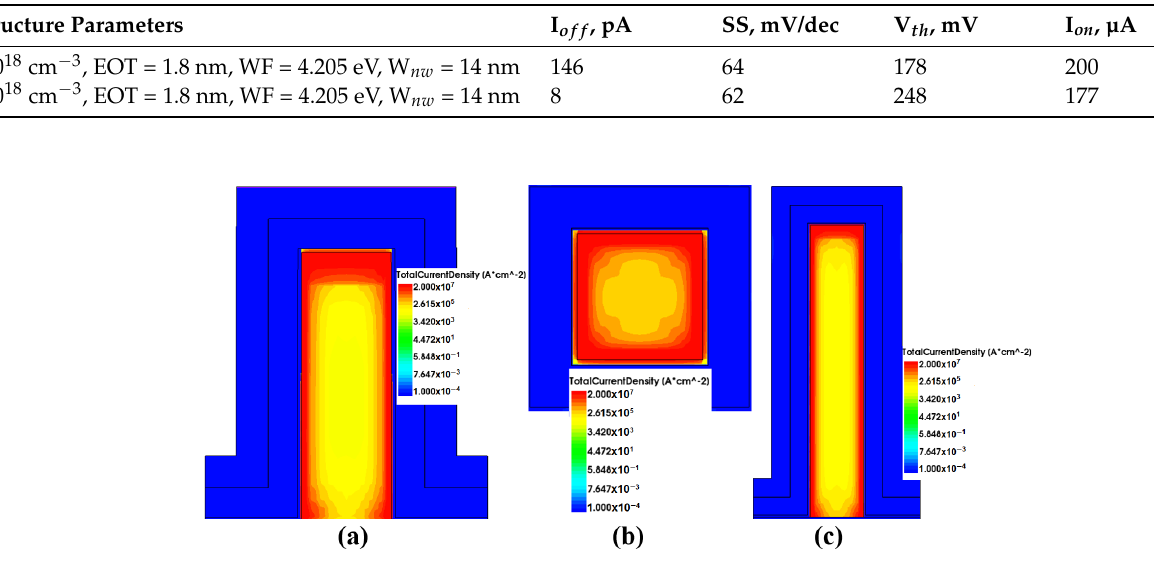
Figure 8. Simulation results; ( a ) current density distribution in the FinFET (height 42 nm) channel; ( b ) current density distribution in the NWFET channel; ( c ) current density distribution in the FinFET (height 77 nm).